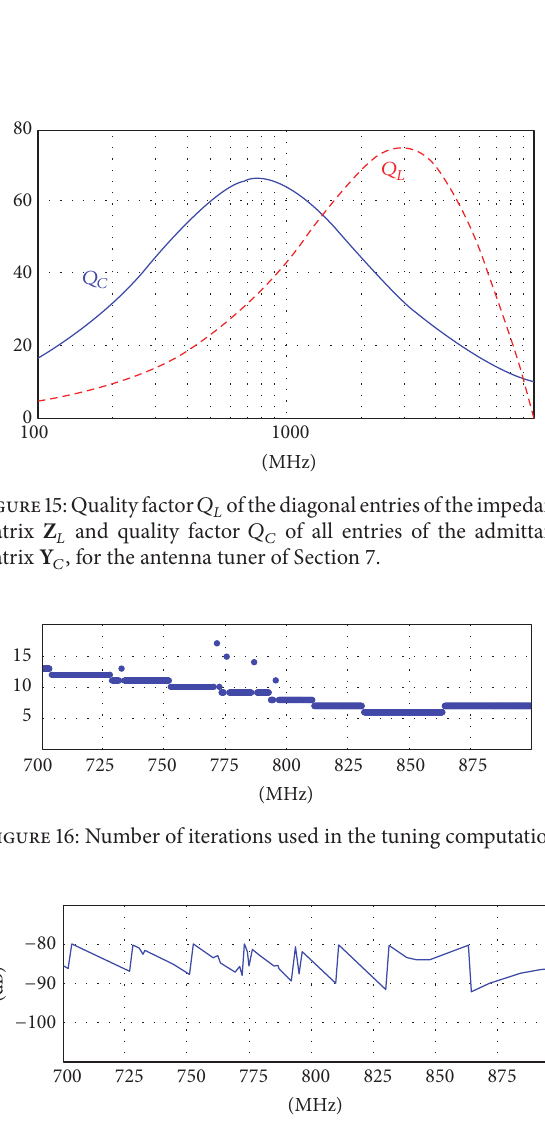
Figure 17: The return figure at the end of the tuning computation.